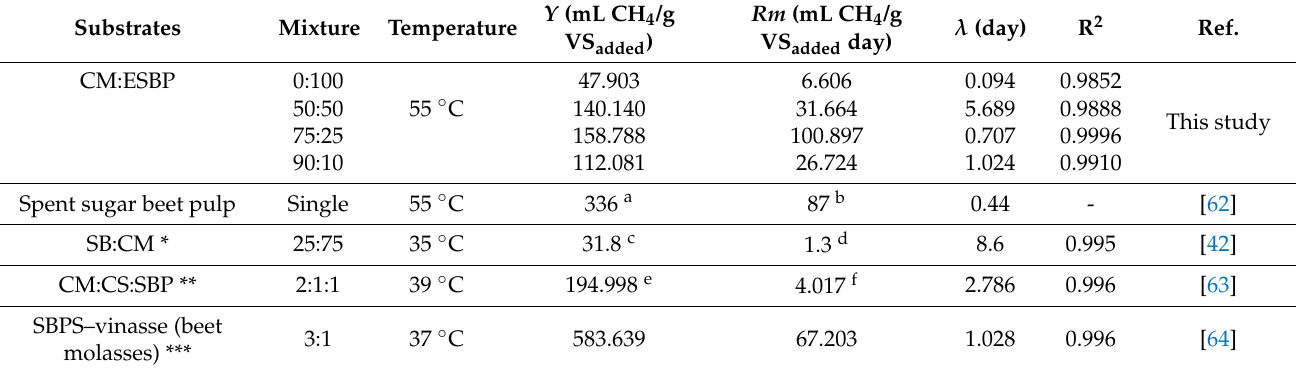
Table 4. Parameters obtained in the Gompertz